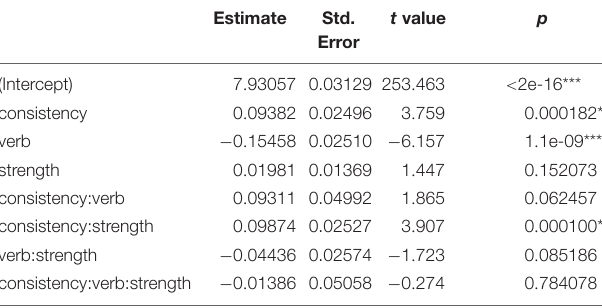
TABLE 4 | Model output of Experiment